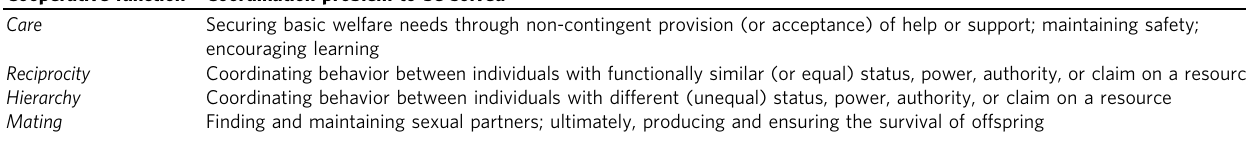
Table 1 Cooperative functions of dyadic relationships, adapted from Bugental 39 . Cooperative function Coordination problem to be solved Care